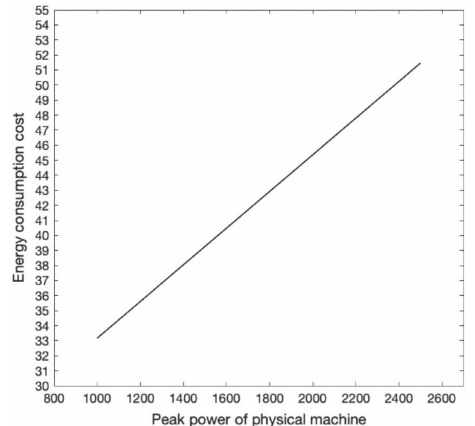
Figure 8. The effect of the peak power of the physical machine on energy consumption cost.